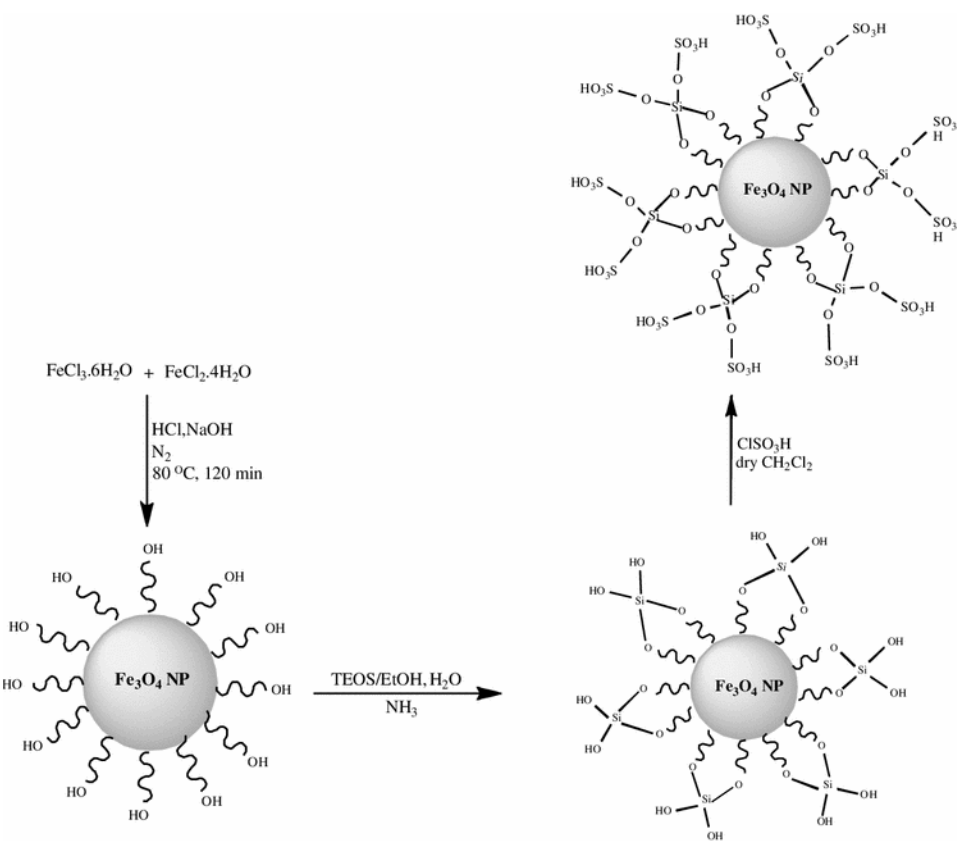
O nanoparticles. Reproduced from Nazifi et al. [42]. 3 4